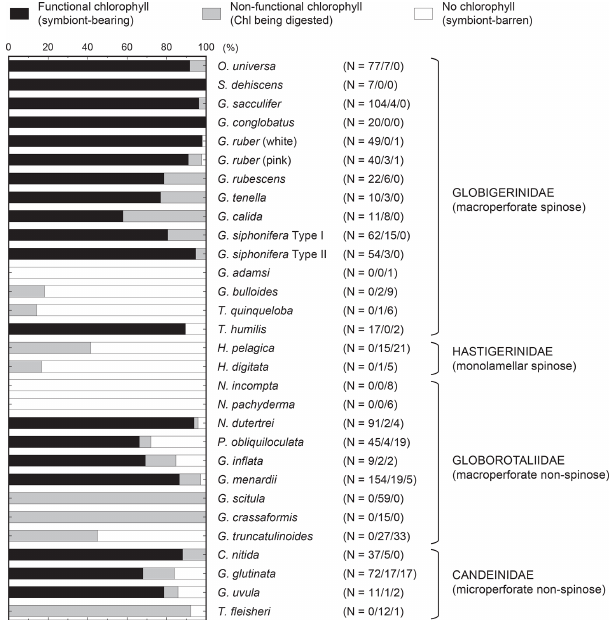
Figure 4. Workflow of this study and four indices used to charac- terize photosymbiosis. Firstly, individual specimens were identified to morphospecies level, measured for the test size, and analyzed with active fluorometry to check the functionality of chlorophyll. Based on the fluorescence results, intracellular chlorophyll types (status) were categorized into three groups: functional chlorophyll, non-functional chlorophyll, and no chlorophyll. When chlorophyll was functional, the content of Chl a per individual and the pho- tophysiological parameters were analyzed. Finally, four indices in bold (symbiont possession rate, test size–Chl a relationship, Chl a / biomass and F v /F m ) were derived and used for the char- acterization of photosymbiosis (see text for details).